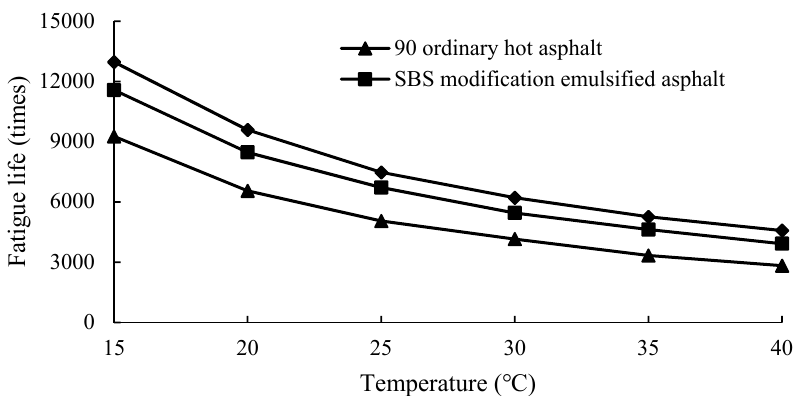
Figure 11. Variation in fatigue life for different waterproof cohesive layer materials at different temperatures.